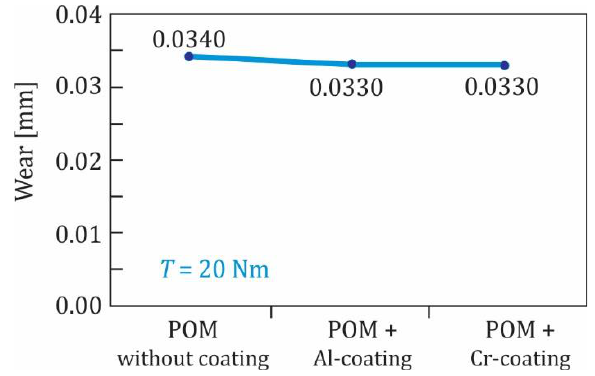
Figure 12. Wear of POM-gears at the torque 20 Nm.